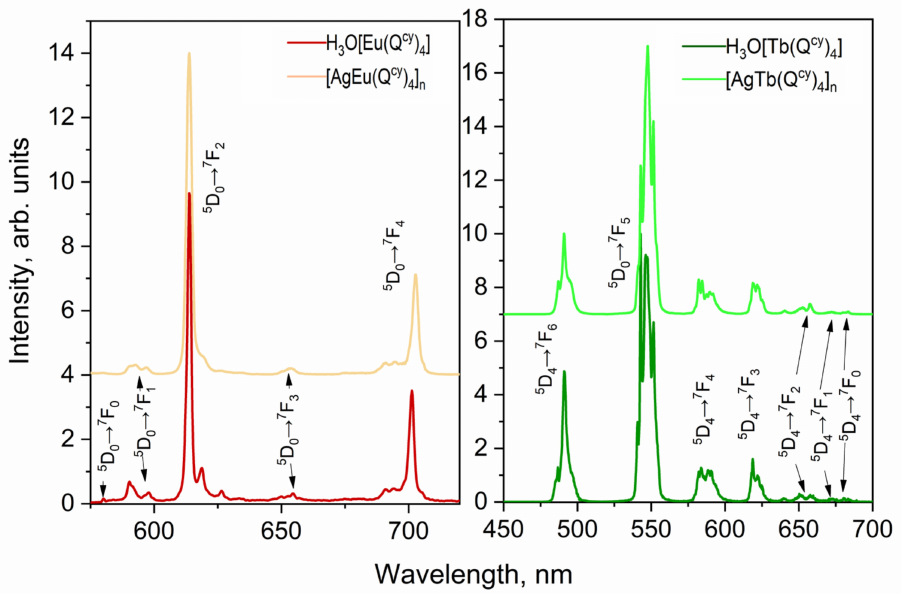
Figure 9. Photoluminescence spectra for Eu 3+ ( 2 and 7 ) and Tb 3+ ( 4 and 9 )